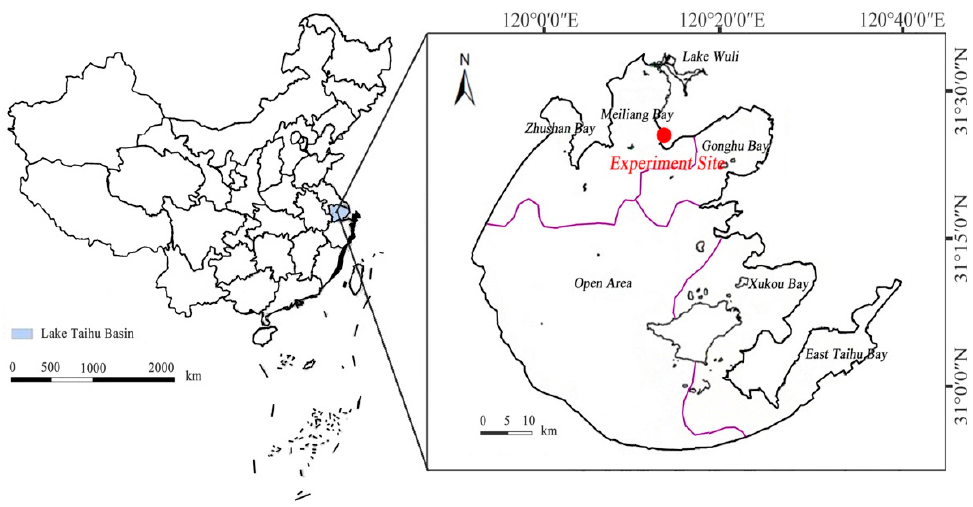
Figure 1. Location of Lake Taihu and experimental site (Lake Taihu Experimental Station).